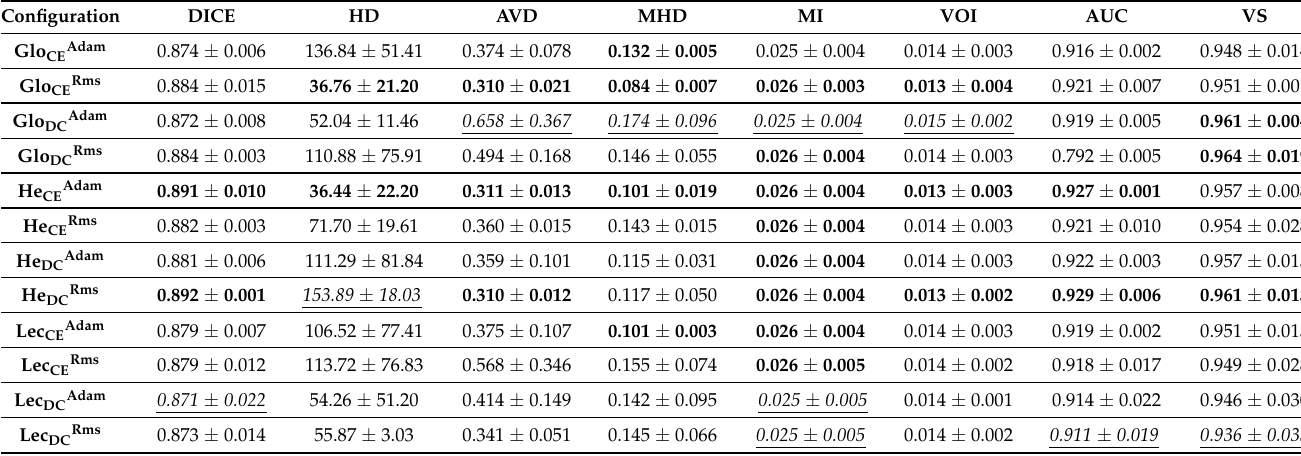
Figure 6. Axial and 3D views of Liver prediction overlayed on ground truth segmentation ( 1a ) using best combination ( Glo tanh ), ( 1b ) using worst combination ( He sigm ) viewed in ITK-Snap Viewer [51]. Table 2. Mean and standard deviation values for Segmentation metrics on Heart Database (higher values represented in bold and lower values in italics with